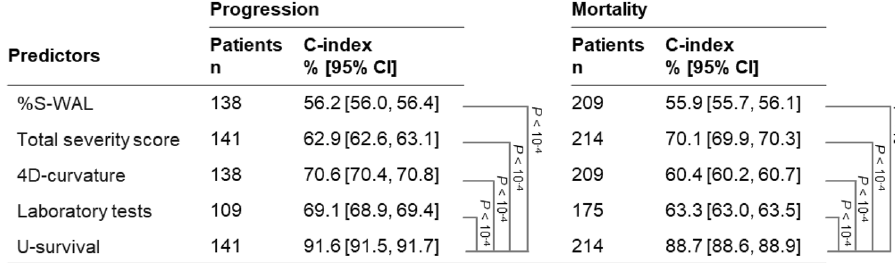
Table 2. Performance of U-survival and the reference predictors in the prediction of the outcomes of COVID- 19 for the subcohorts where all of the available patients were used for each predictor. The table shows C-index values and their 95% confidence intervals (CI) obtained by per-patient bootstrapping with 1000 replicates in the prediction of disease progression (left) and mortality (right). “Patients” columns show the number of patients used for each predictor. The P values were obtained by application of a bootstrap hypothesis test. %S-WAL percentage of well-aerated lung parenchyma.